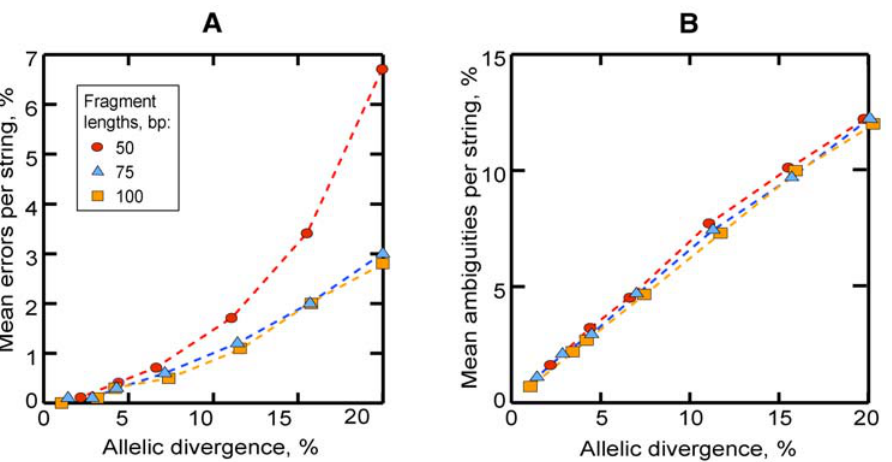
Figure 7. Accuracy of decoding of simulated mixed fragments formed by 5 bp shift at the origin of one of two allelic strings. The horizontal axis represents divergence between the allelic strings forming each fragment. (A) Mean percent of erroneous bases per reconstructed string. (B) Mean percent of ambiguous bases per reconstructed string. Each point represents the mean of 1,000 runs. For SD and additional statistics, see Table S1.